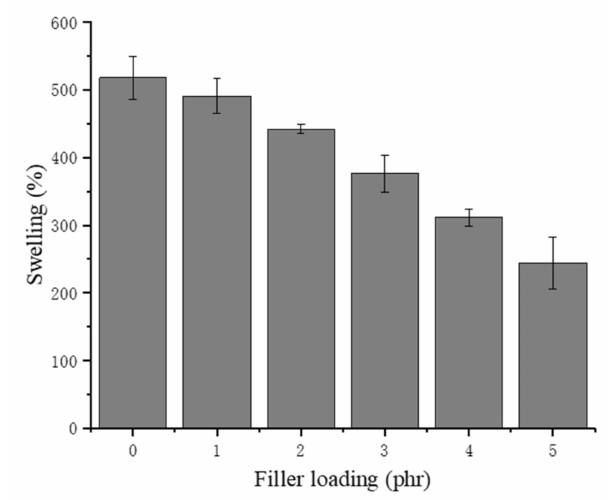
Figure 4. Swelling of